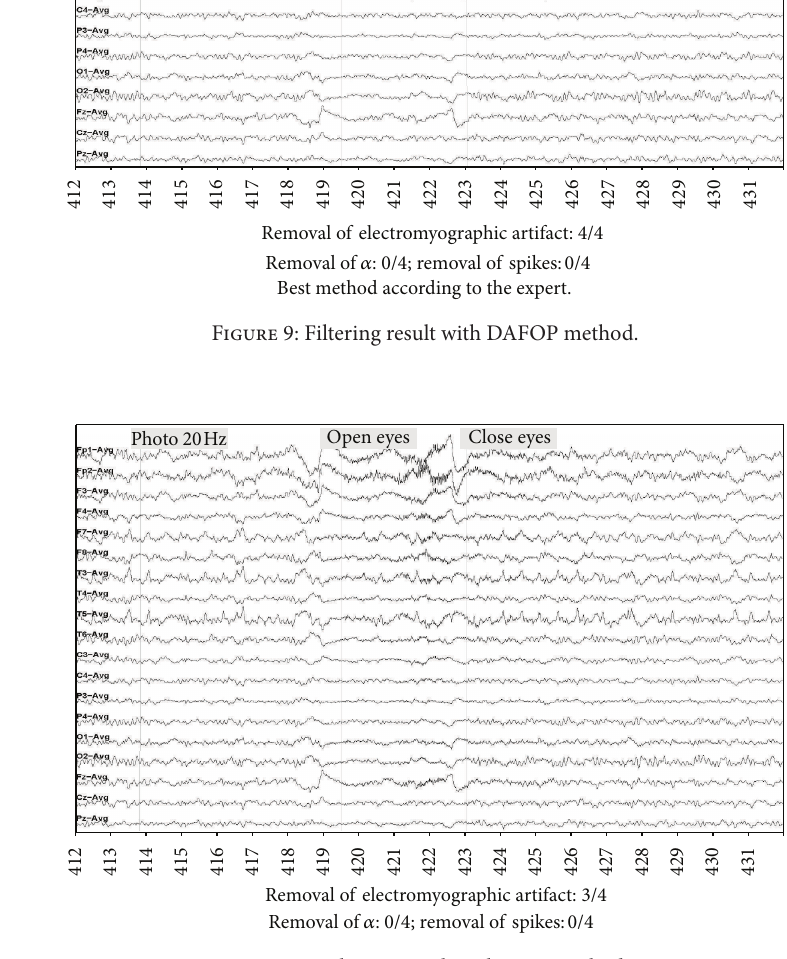
Figure 10: Filtering result with CCA method.